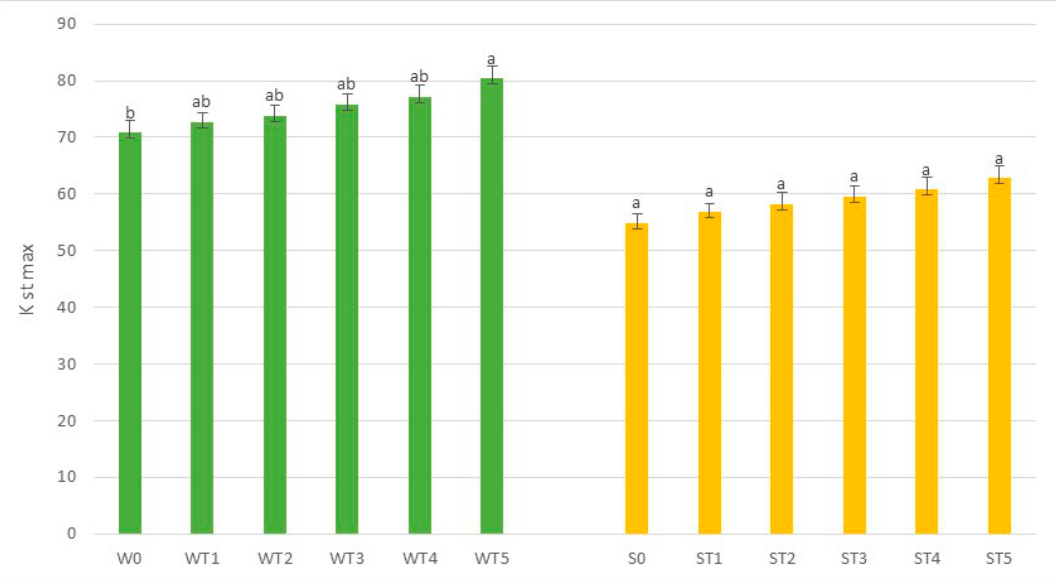
Figure 1. Changes in the dust explosion index in the samples of biomass and torrefied materials. Statistically significant differences between marked by different letters ( p ≤ 0.05).